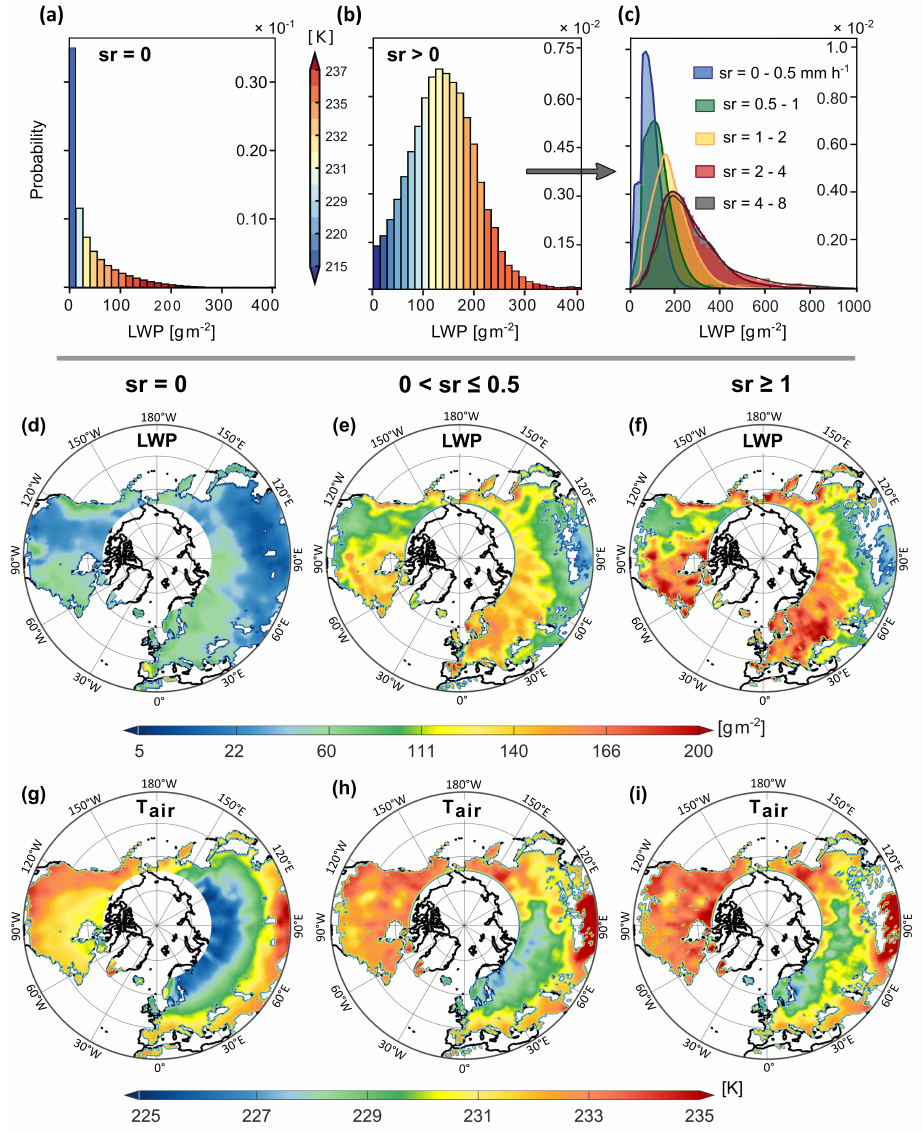
Figure 2. The effects of different overland snowfall rates (sr) on frequency and spatial distribution of cloud LWP over the NH: probability distribution functions of LWP for sr = 0 ( a ), sr > 0 ( b ) and 0 < sr < 8 mmh − 1 ( c ); spatial distribution of the mean LWP ( d – f ), and the T air ( g – i ) for non- precipitating ( d , g ), 0 < sr ≤ 0.5 mmh − 1 ( e , h ) and sr ≥ 1 ( f , i ). The histograms are color coded to represent corresponding mean T air temperatures. Note that the color represents the multi-year average of T air for each LWP bin (in the top row), the multi-year gridded average of LWP (second row), and the multi-year gridded average of T air (bottom